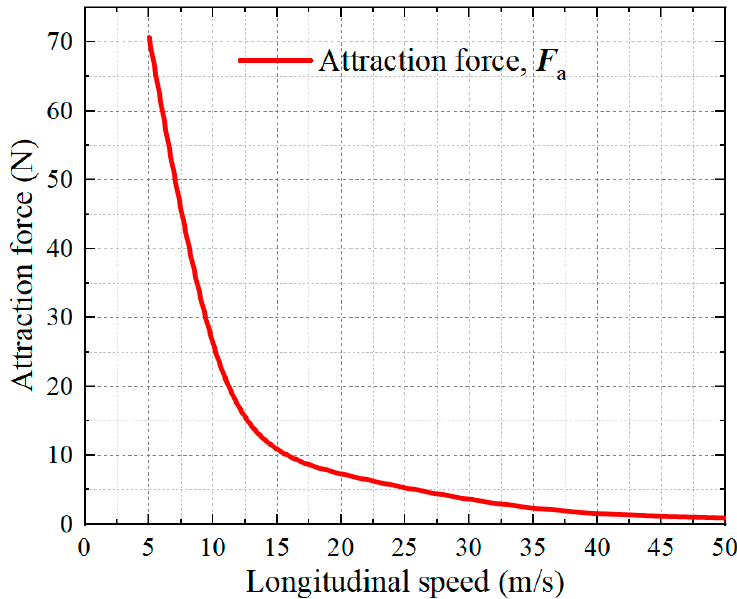
Figure 10. The attraction force as function of the longitudinal speed at a working gap of 27 mm.